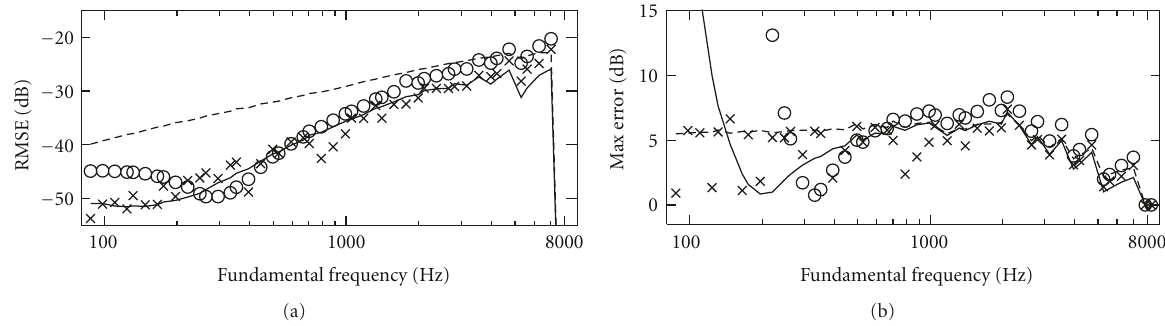
Figure 7: (a) Root mean squared error (RMSE) of the harmonics and (b) the maximum absolute harmonic magnitude error of the PD model (solid line) and the reset-corrected model of [19] (dashed line) as a function of f 0 between 86Hz and 8.3kHz. The RMSE and the maximum absolute harmonic magnitude error of PD models that use the estimated parameter values and a single parameter value estimated for f 0 = 524Hz at all frequencies are plotted with crosses and circles, respectively, for